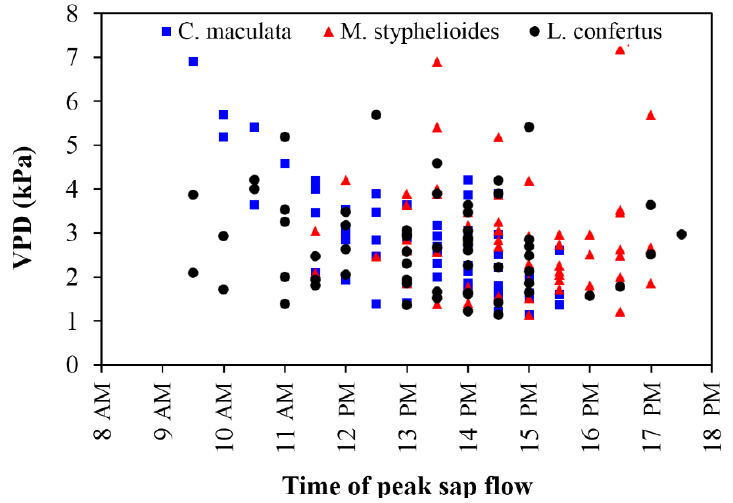
Figure 14. Daily sap flow peak time against daily maximum VPD during summer for the C. maculata , M. styphelioides and L. confertus used in these experiments .